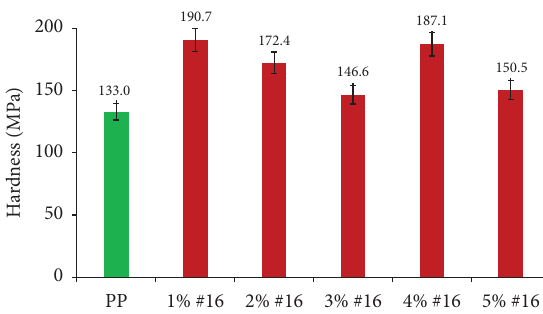
Figure 3: Hardness values for pure PP and #16 Table 2: Summary of three-point bending and hardness tests for pure PP and #16 samples.